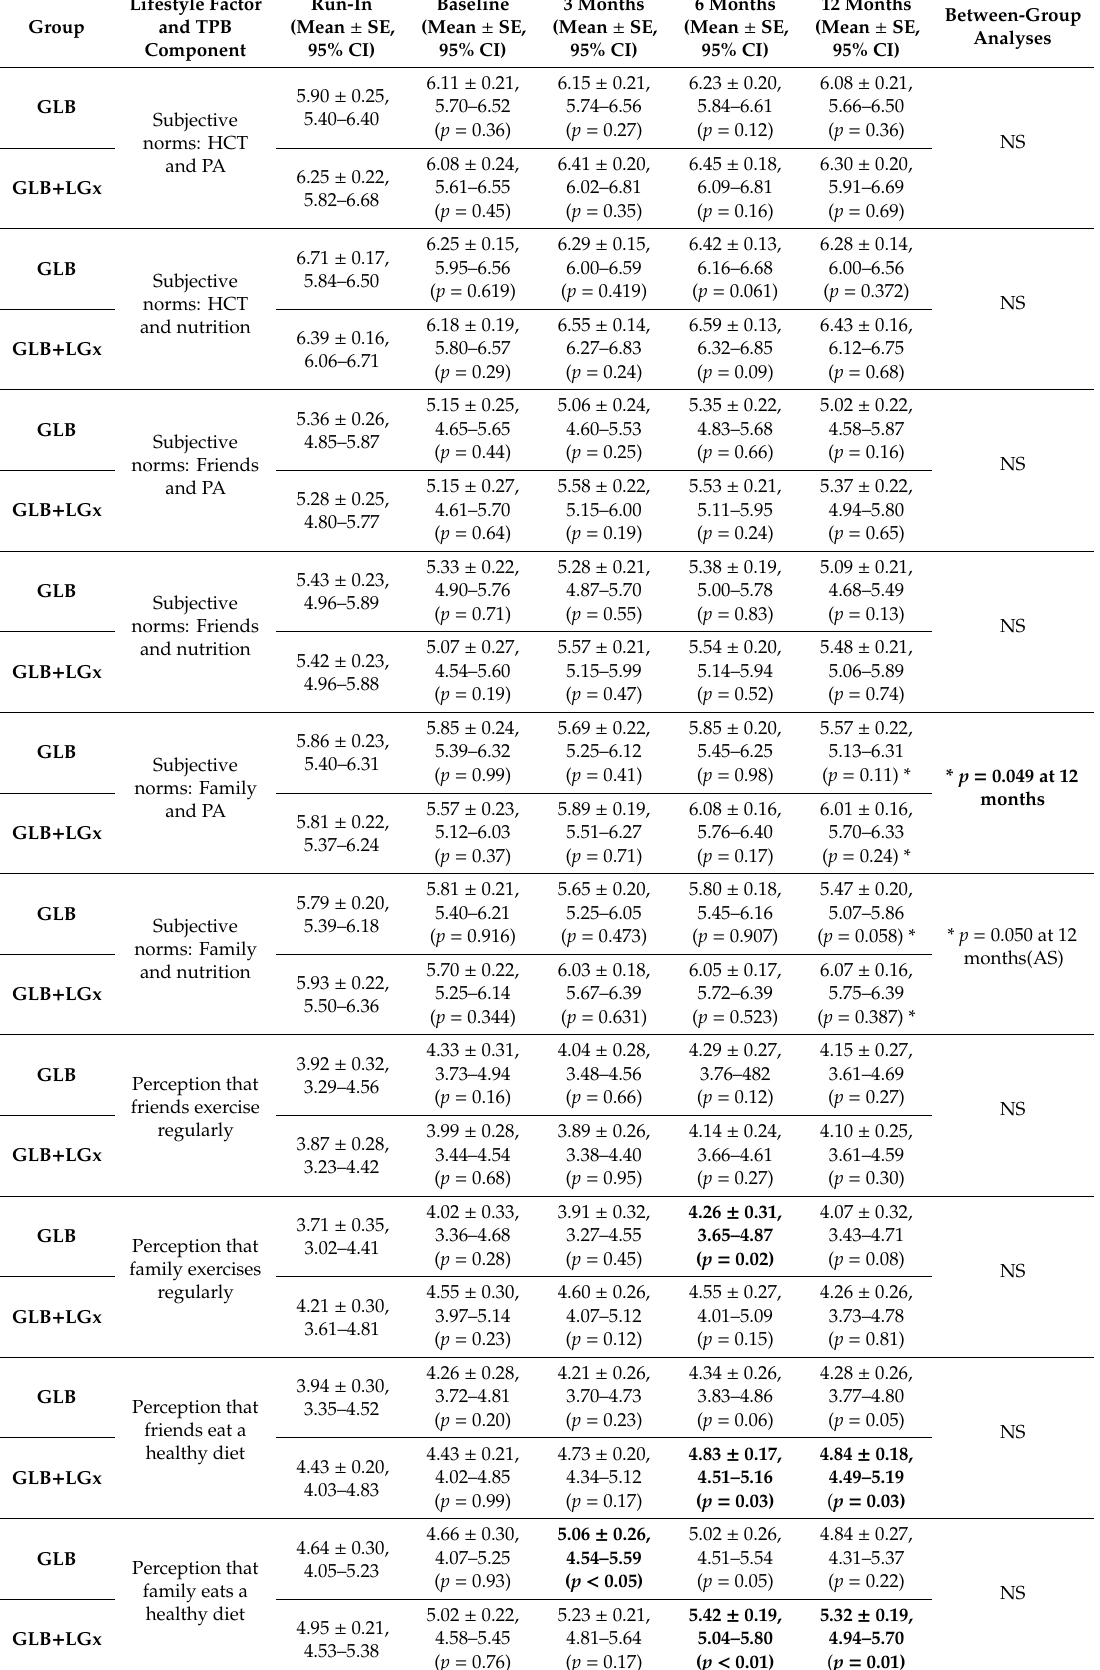
Table 2. Change in subjective norms by intervention group over 12-month